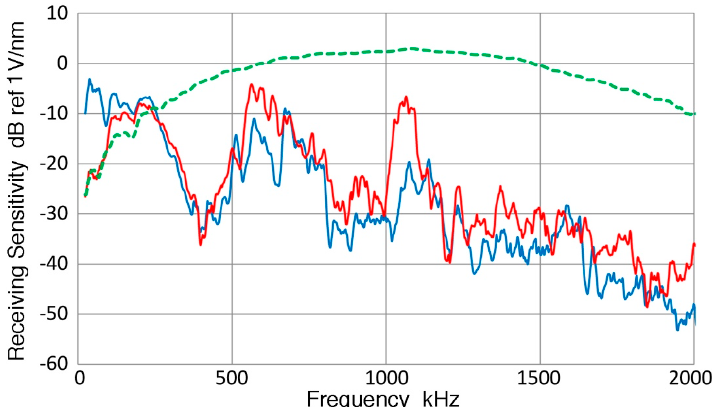
Figure 12. Receiving sensitivity of Olympus V103. The displacement receiving sensitivities to bar waves are shown in blue curve for the present work and in red curve from the old data (reproduced with permission from [8]. Copyright AE Group, 2010). Green curve is the displacement receiving sensitivity to normally incident waves [4].